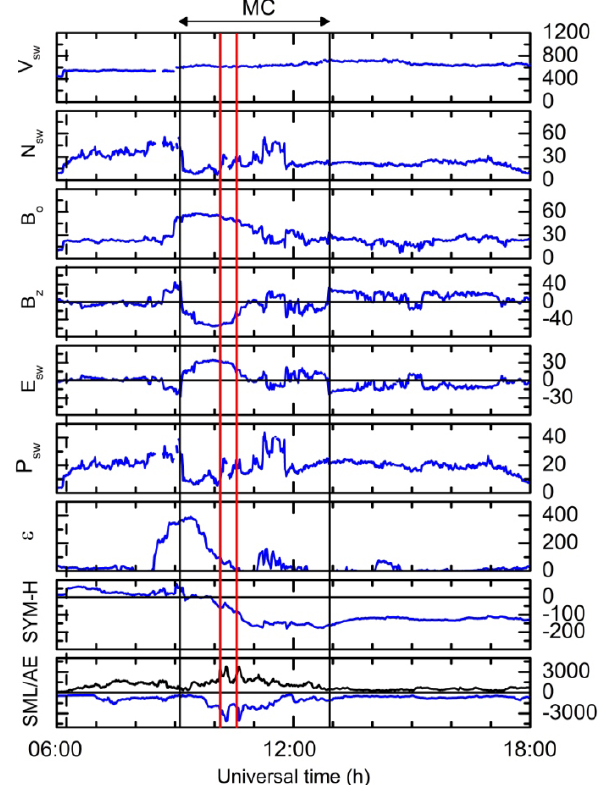
Figure 4. Interplanetary parameters during two SSSs occurring on 24 August 2005. The format is the same as in Fig.